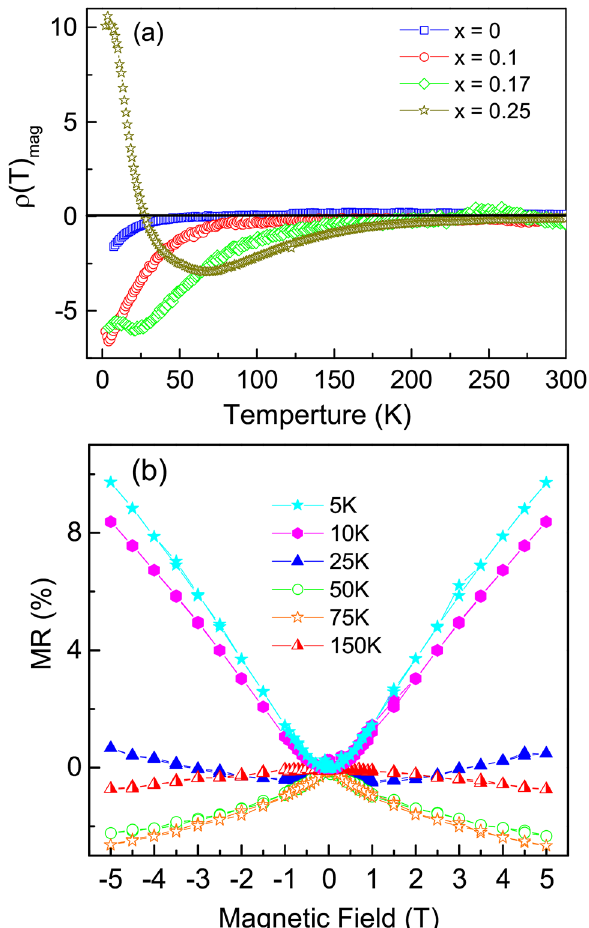
Figure 11. ( a ) Magnetoresistance measured as the function of temperature in presence of a fixed 5 T magnetic Cr field for all Fe 2 Ti 1 x x Sn compositions. ( b ) Isothermal magnetoresistance measured as the function of applied − field, for Fe 2 Ti 0.75 Cr 0.25